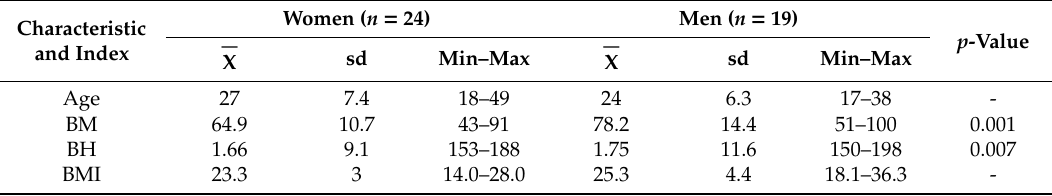
Table 1. Characterization of study participants (BM—body mass, BH—body height, and BMI—body mass